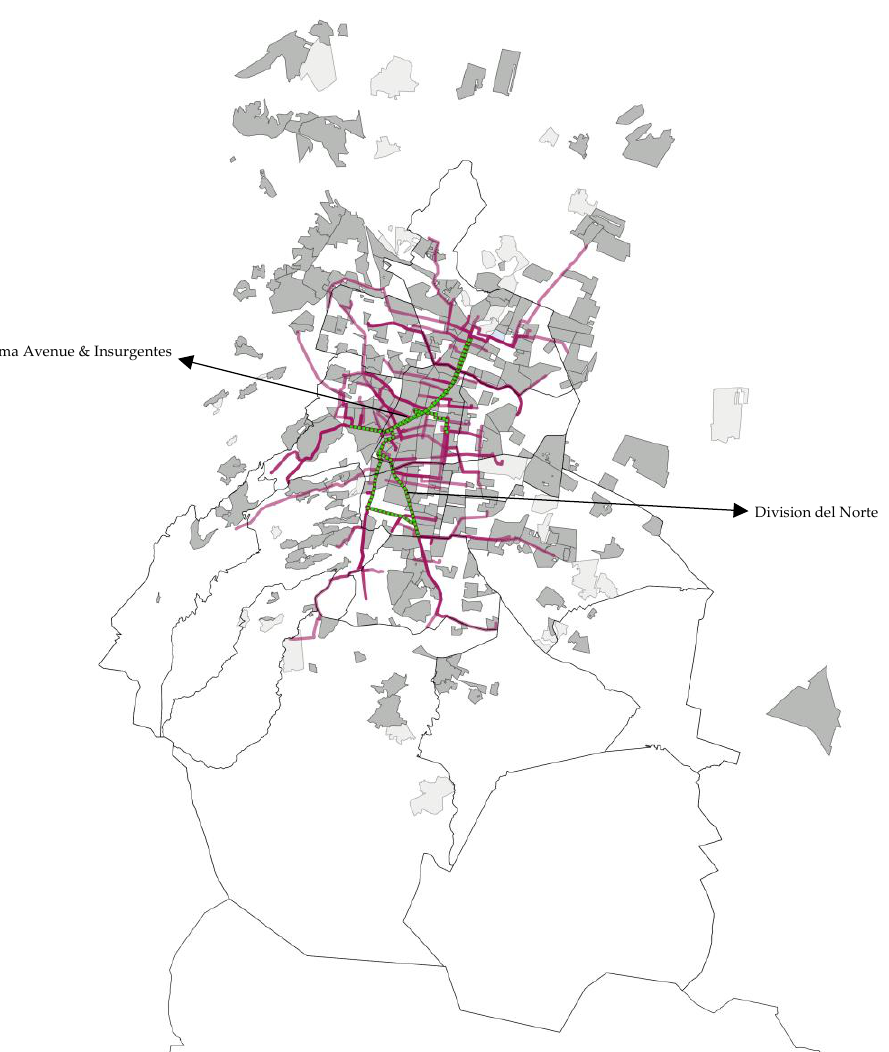
Figure 1. Map with the distribution of the participants and routes. México City, 2017 – 2018. Green line — program route; purple line — participants ’ route; shadows — areas where participants live (dark shadows — people from high-income areas, light shadows — people from middle-income areas).